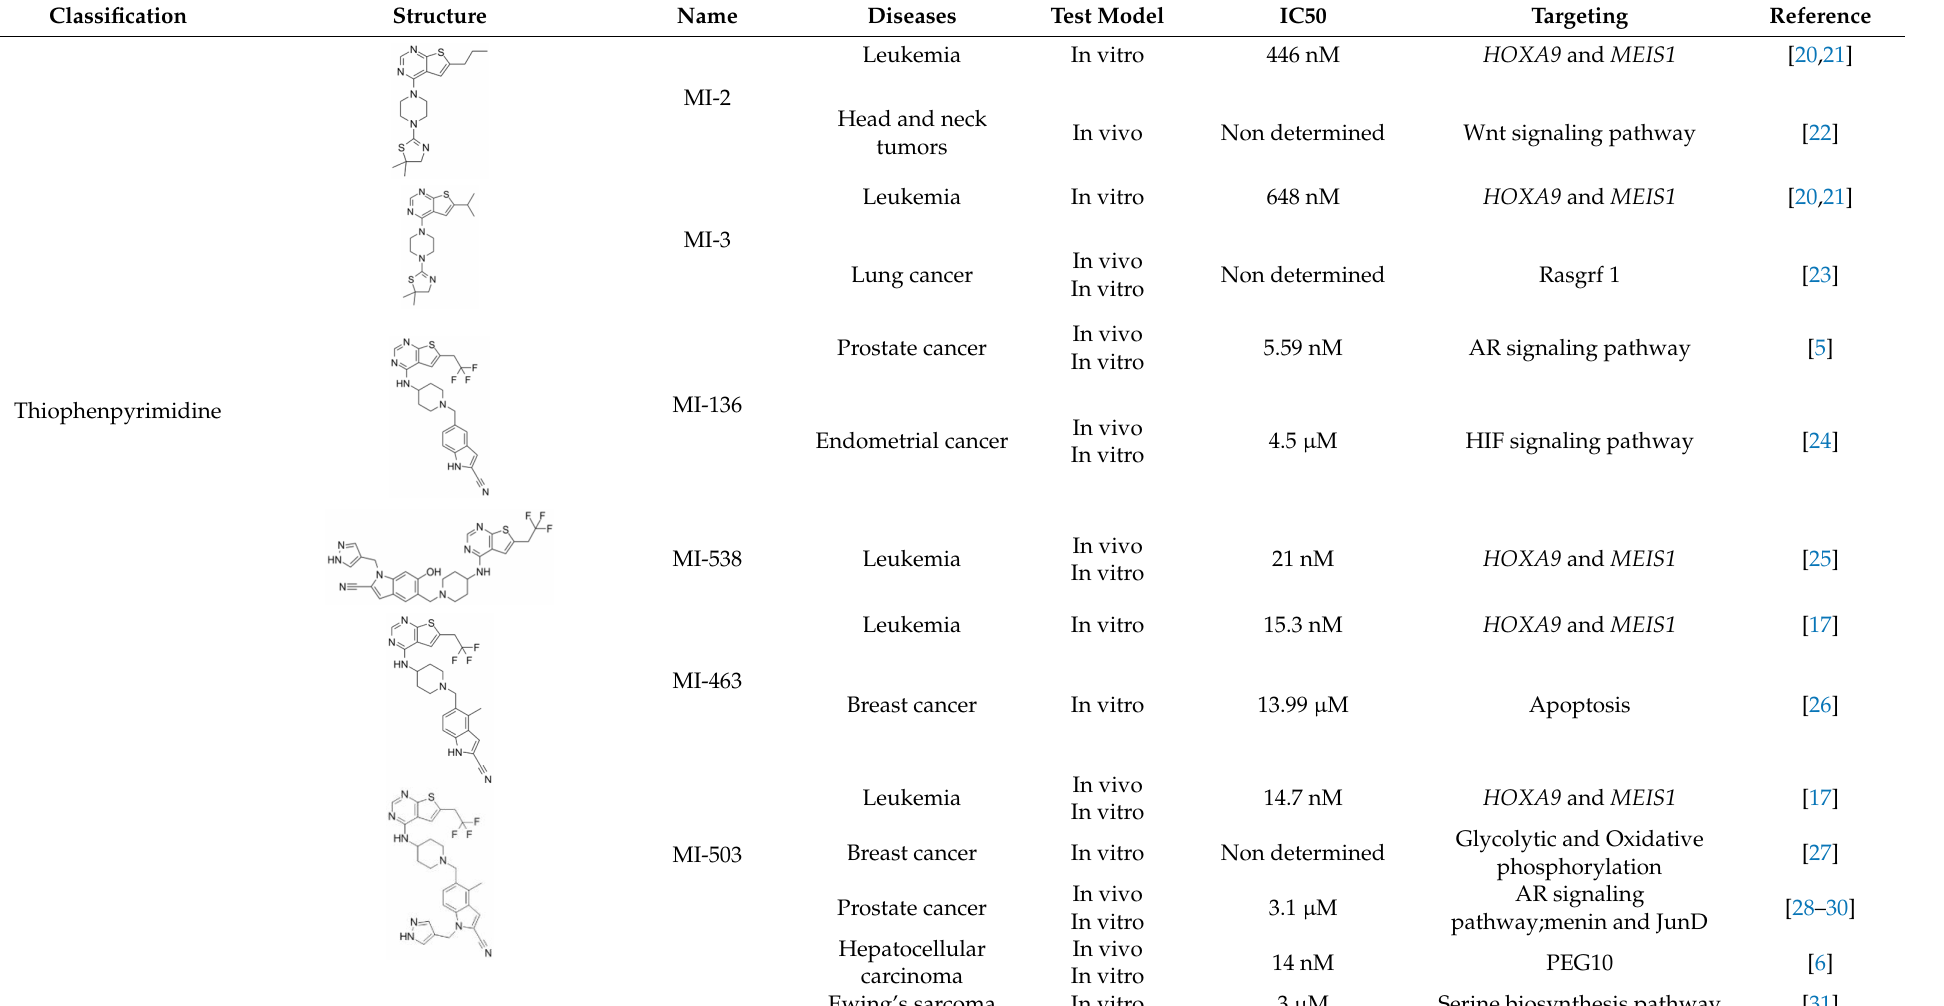
Table 2. Summary of thiophenpyrimidine inhibitors tested against various